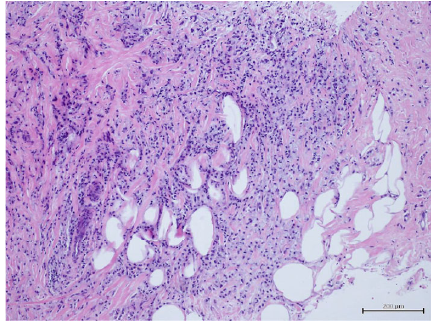
Figure 8: Right breast lesion biopsy showing invasive lobular carcinoma, arranged in sheets, cords, and small